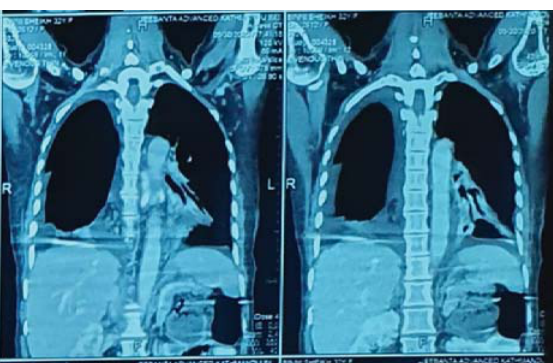
Figure 4. Postoperative CT scan of Chest and Abdomen